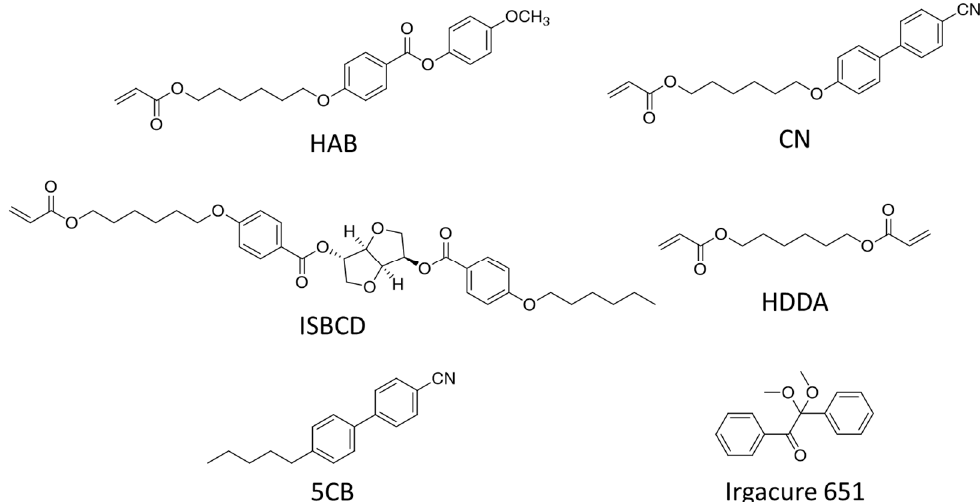
Scheme 1. Chemical structures of the LC monomers (HAB and CN), chiral monomer (ISBCD), cross-linker (HDDA), plasticizer (5CB), and photoinitiator (Irgacure 651) used to synthesize N* LC Table 1. Monomer mixtures for synthesizing N* LC ( x ) elastomers.